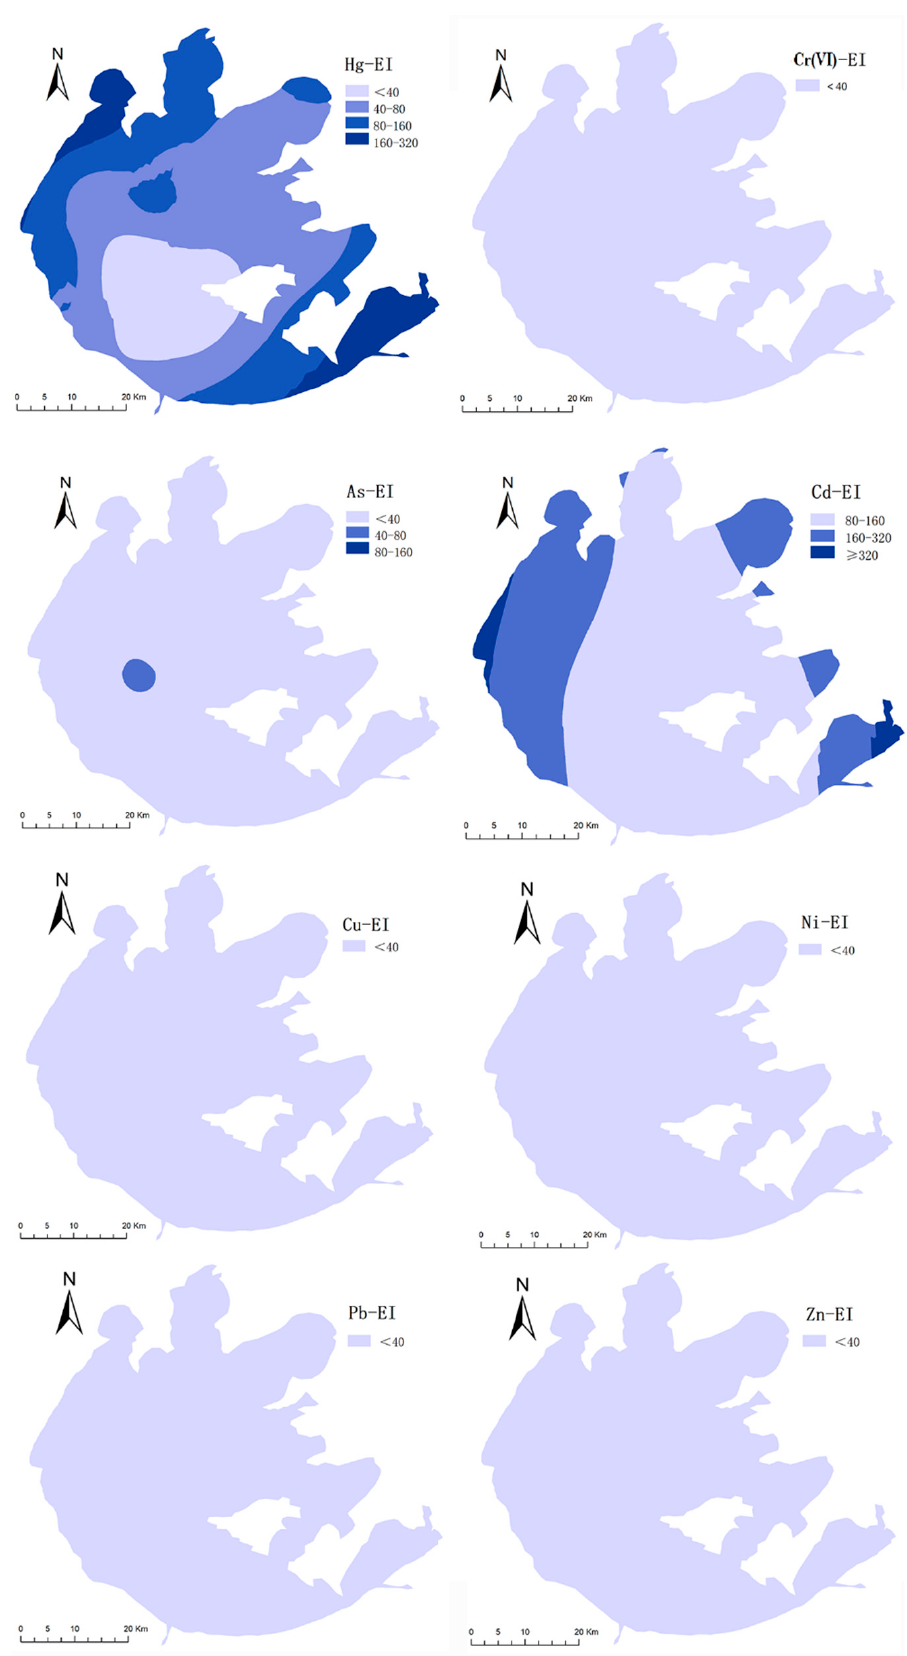
Figure 5. Spatial distributions of EI index for individual heavy metals in sediments.